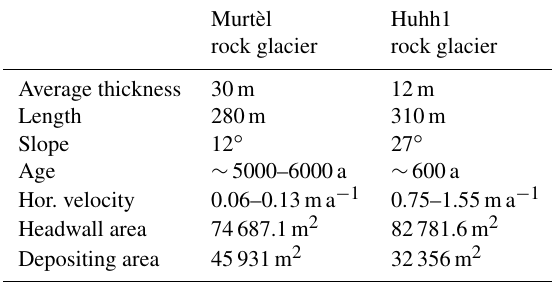
Table 1. Characteristics of the two selected rock glaciers (excluding their talus slopes). The data sources are cited in the text. Murtèl Huhh1 rock